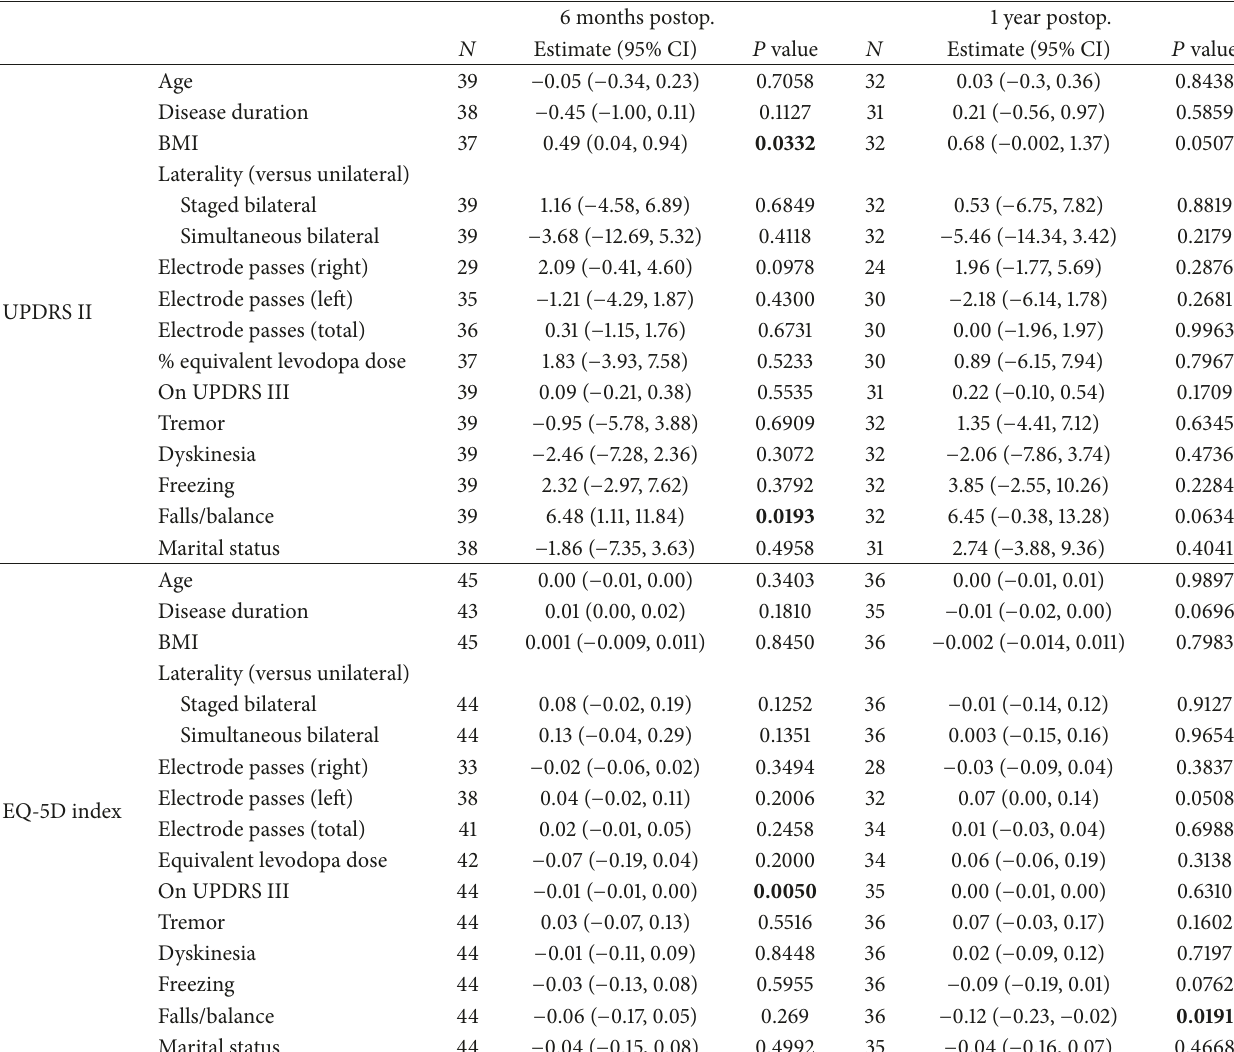
Table 1: Beta estimates for health status measures collected at 2 follow-ups. 6 months postop. 1 year